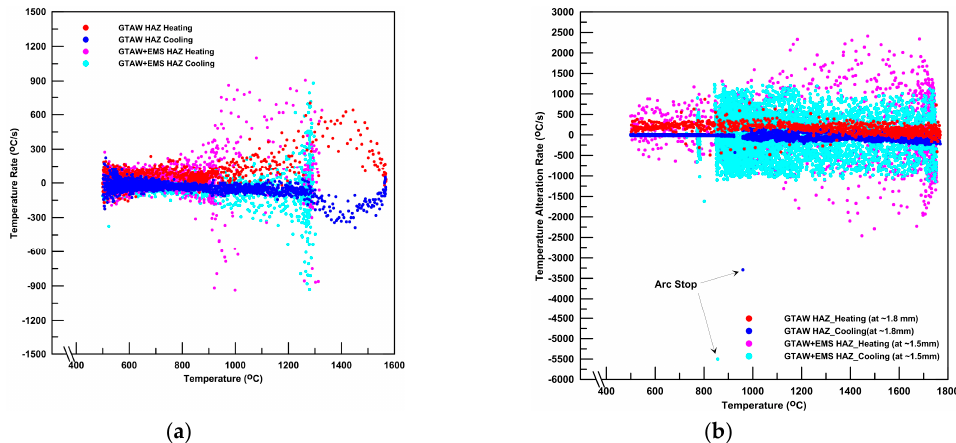
Figure 12. The relationship between the temperature and the TARs of the HAZ area: ( a ) high-speed pyrometer and ( b ) R-type thermocouple.